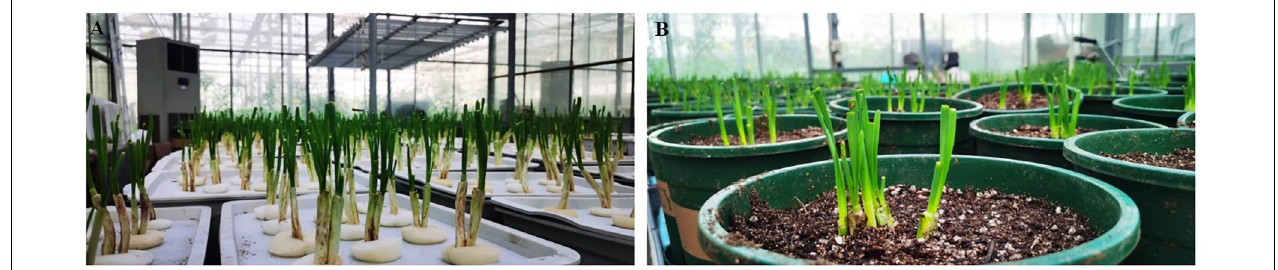
FIGURE 1 | Hydroponic (A) and substrate-grown (B) Chinese chives grown in a glass solar greenhouse.